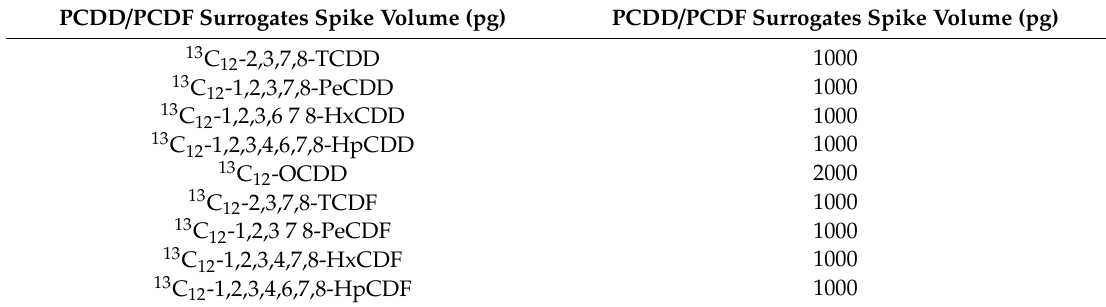
Table 1. Composition of internal standard surrogate mixtures used to spike all samples analysed. PCDD / PCDF Surrogates Spike Volume